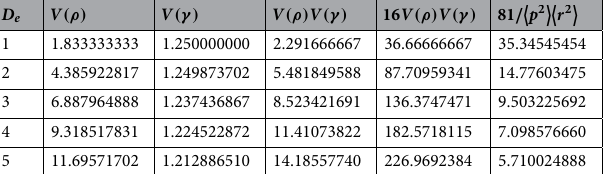
p 2 r 2 and (cid:31) (cid:30)(cid:31) (cid:30)